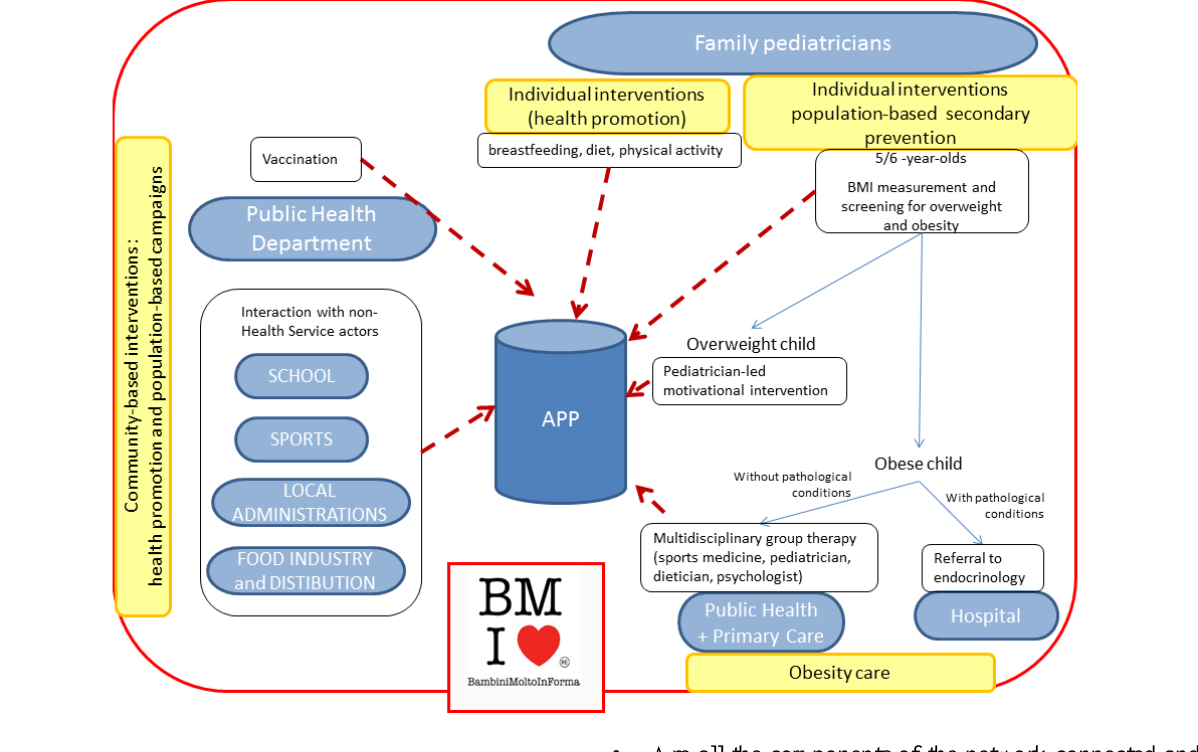
Figure 1. Scheme of the interactions between the primary and secondary prevention and obesity care. The figure also depicts the initial project of an app to improve the service